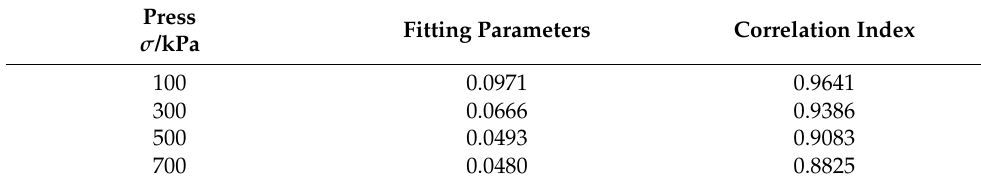
Table 10. Fitting parameters of lg ε -lg t relation of Changsha silty clay.